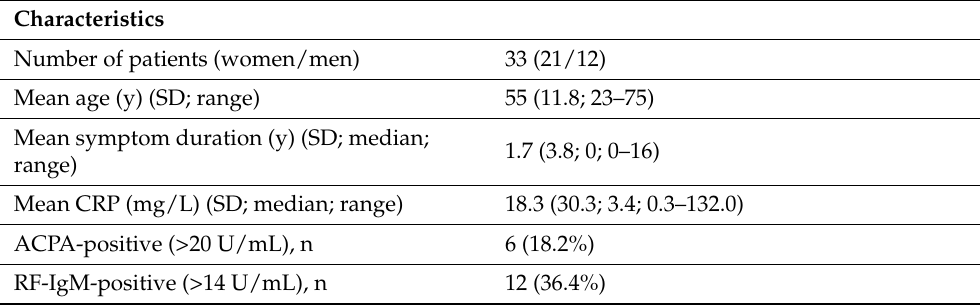
Table 1. Results of the descriptive analysis. ACPA = antibodies against citrullinated